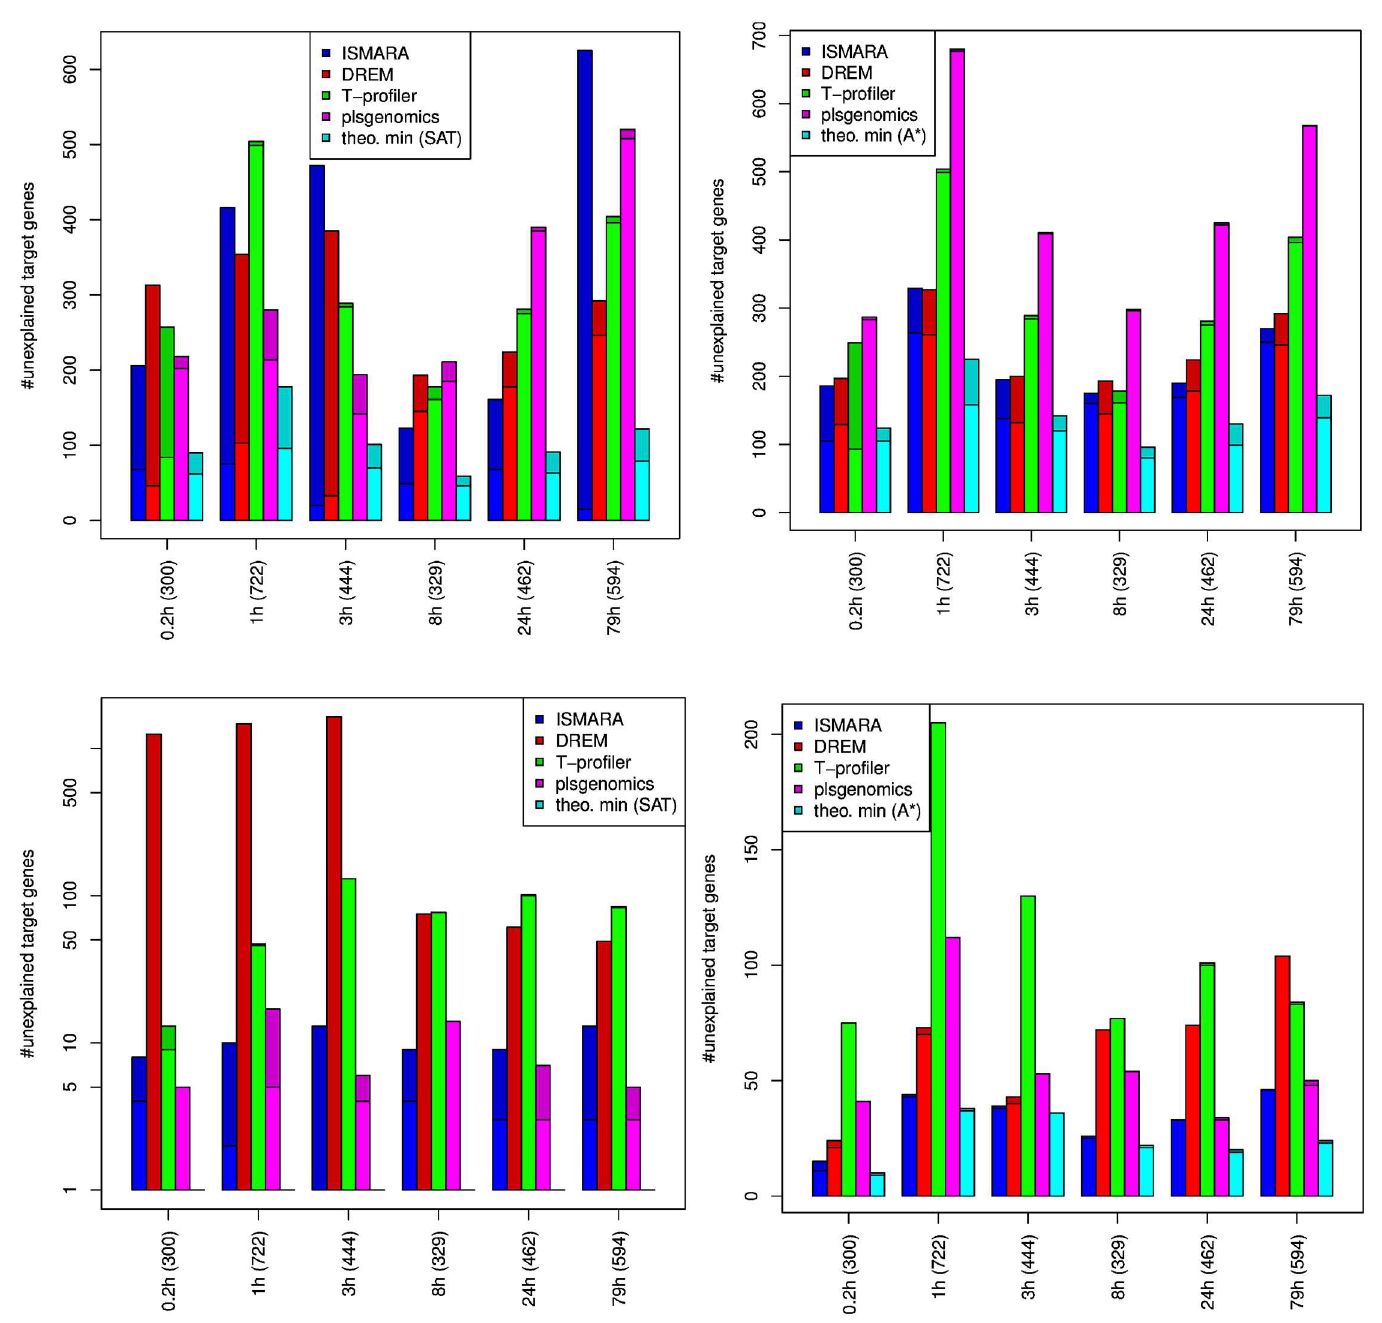
Fig 3. The number of unexplained target genes (#UTG) for the respiratory shift from 20.9%-oxygen time series and the YEASTRACT (top) and ISMARA (bottom) network. On the left all predictedTFs are used and on the right the 10 most important TFs only. The brighter part of the bars indicates how many of the UTGs have changed significantly in the data. The darker part of the bars correspondto the UTGs which are unchanged.For each condition the number of differential genes is given in parentheses.